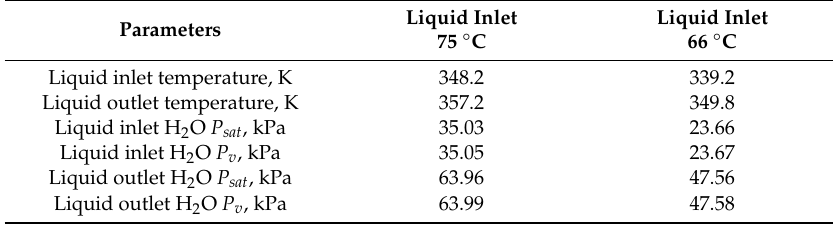
Table 9. Changes in water vapor pressures with liquid inlet temperature.